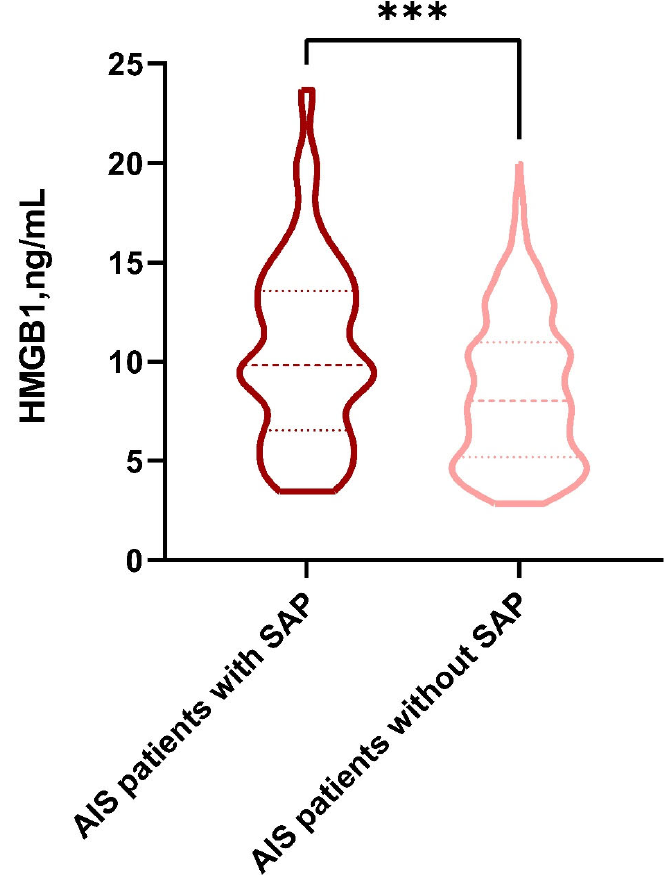
Figure 2. The violin plot in the distribution of HMGB1 concentrations in the SAP group and the non ‐ SAP group. HMGB1, high ‐ mobility ‐ group box 1; SAP, stroke ‐ associated pneumonia. *** ： p < 0.001. As shown in Figure 3, the incidence of SAP was elevated among patients in the higher quartile of the HMGB1 group than those in the lower quartile of the HMGB1 group. As indicated by Table 2, patients in the fourth quartile of the HMGB1 group had the highest likelihood of experiencing SAP (OR = 3.687; 95% CI: 1.851–7.344; unadjusted model, using the first quartile of HMGB1 group as reference). This association remained significant in the age ‐ and sex ‐ adjusted model (OR = 3.511; 95% CI: 1.725–7.147) as well as the multivar ‐ iable ‐ adjusted model (OR = 2.701; 95% CI: 1.045–6.981). HMGB1 was also independently associated with SAP as a continuous variable in the unadjusted model (OR = 1.132; 95% CI: 1.069–1.199), age ‐ and sex ‐ adjusted model (OR = 1.131; 95% CI: 1.066 ‐ 1.200), and mul ‐